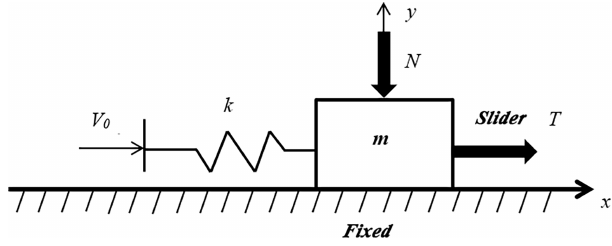
Figure 1. The single block